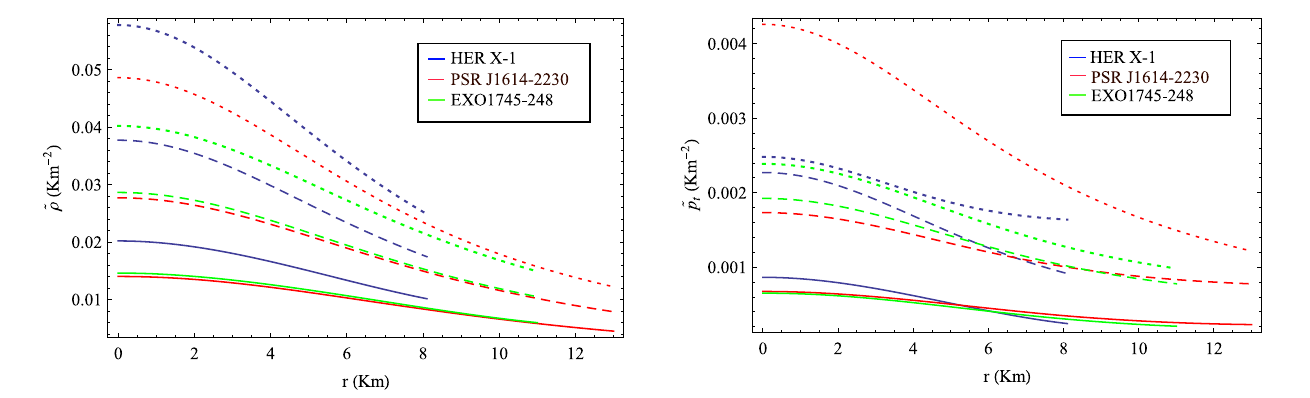
Fig. 4 Radial variation of tangential pressure ( ˜ p t ) for different com- pact objects as indicated in the figure. Here plots with solid, dashed and dotted lines correspond to D = 4 , 5 and 6 respectively. To obtain the plots we choose (i) α = 0 . 4, γ = 0 . 45 when D = 4; α = 0 . 3, γ = 0 . 25 when D = 5 and α = 0 . 25, γ = 0 . 2 when D = 6 for HER X-1, (ii) α = 0 . 4, γ = 0 . 5 when D = 4; α = 0 . 3, γ = 0 . 25 when D = 5 and α = 0 . 2, γ = 0 . 15 when D = 6 for PSR J1614-2230, (iii) α = 0 . 4, γ = 0 . 5 when D = 4; α = 0 . 3, γ = 0 . 2 when D = 5 and α = 0 . 2, γ = 0 . 25 when D = 6 for EXO1745-248